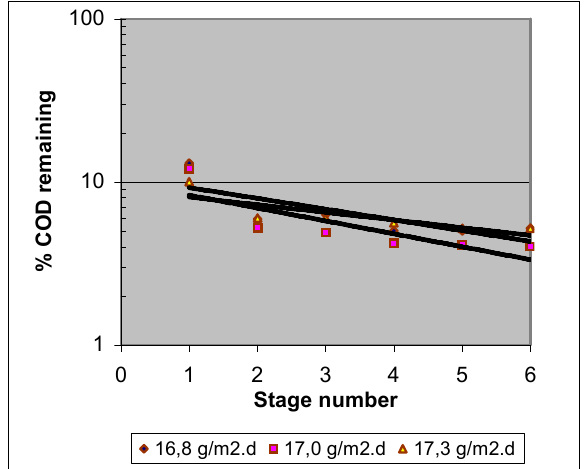
Figure 8: Percent COD remaining per stage for synthetic wastewater at various organic concentrations and flow rate but with constant organic loadings.